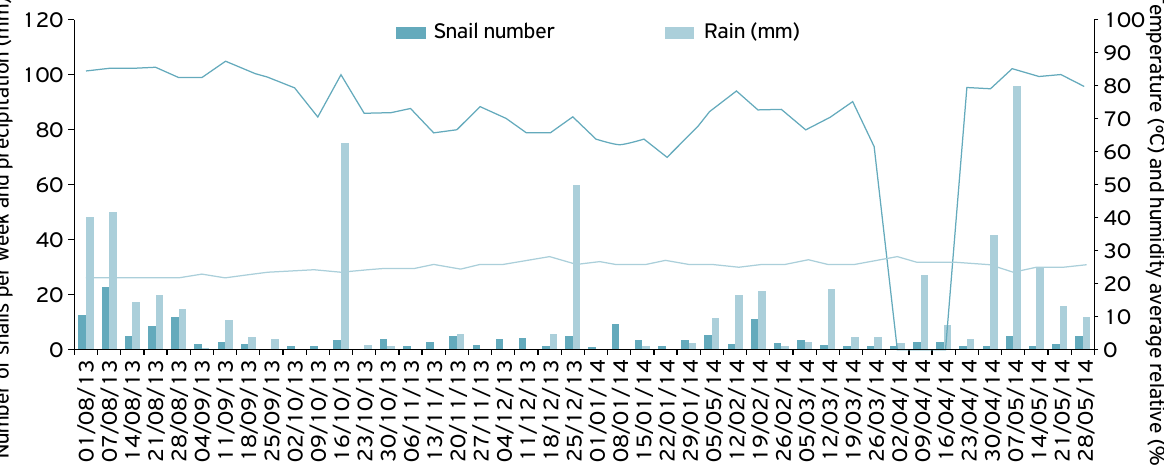
Figure 3. Weekly variation of adult of Achatina fulica collected from August 2013 to May 2014 in lettuce area ( Lactuca sativa L.), in the location of Batingas, Arapiraca, Alagoas,